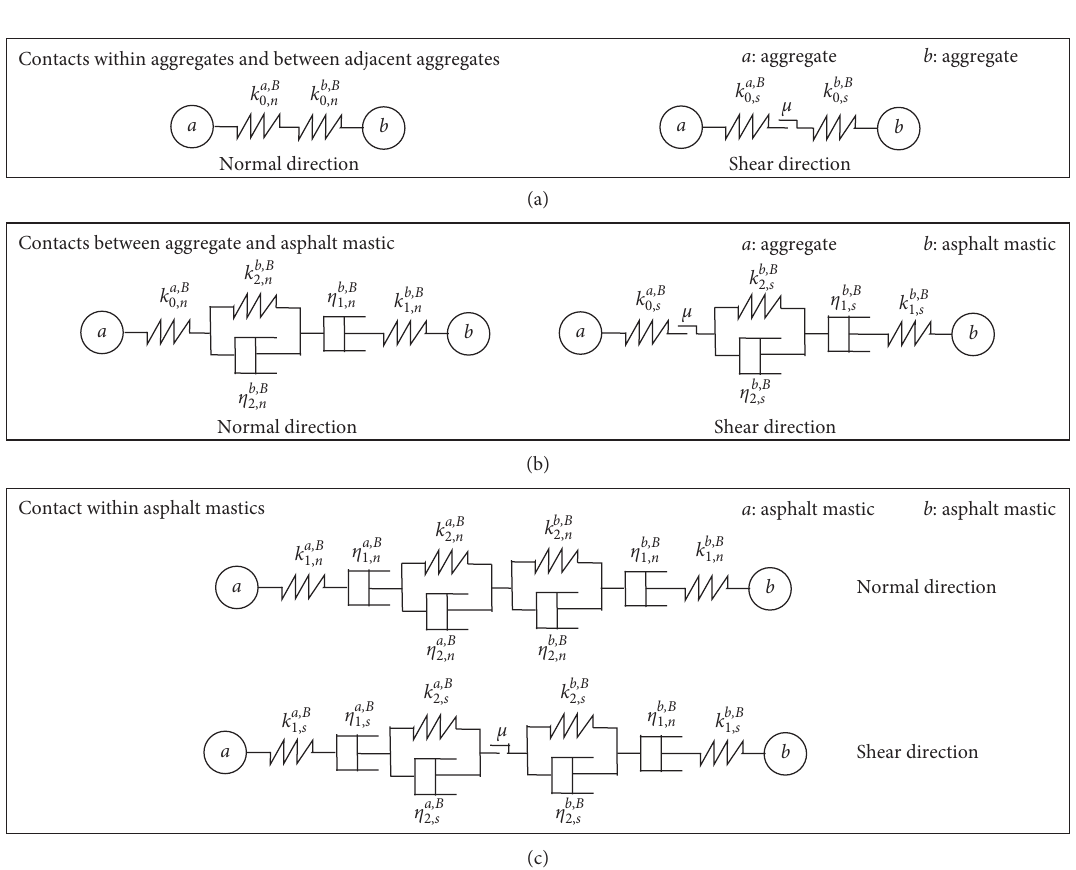
Figure 2: Constitutive relation of contacts in numerical samples using the